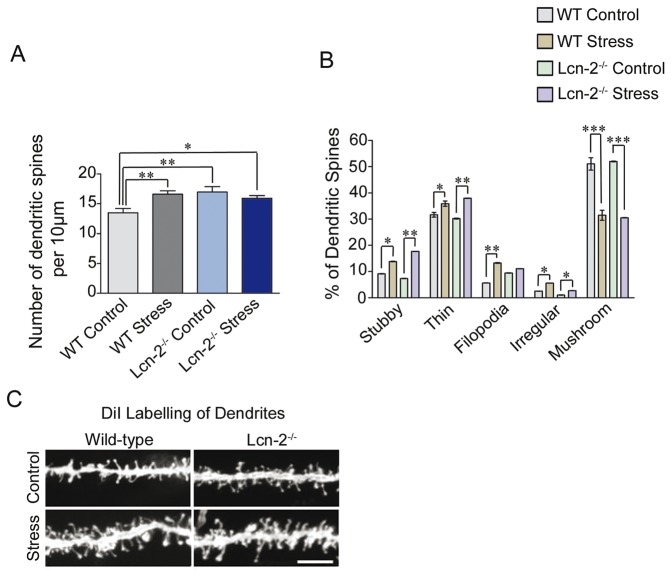
Lipocalin-2 regulates basal and stress-induced changes in dendritic spine density.Dendritic spine density in DiI-labeled neurons was analyzed in basolateral amygdala of wild-type and Lcn-2−/− mice before and after restraint stress. (A) Stress caused an increase in spine density in the neurons of BLA in wild-type mice reaching density observed in Lcn-2-deficient stress naïve mice. (B) Stress induced also significant decrease in proportion of mushroom spines observed in both wild-type and Lcn-2−/− strains. Those changes were accompanied by increase in other morphological groups of spines (B). Panel C represents the example of DiI stained neurons. *p<0.05; **p<0.01; ***p<0.001. Data are expressed as mean ± SEM.